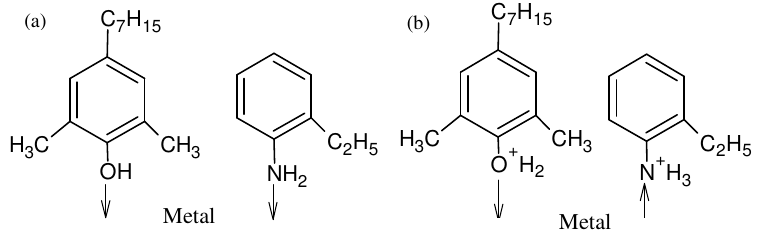
Figure 10. Adsorption model for the binary inhibitor mixtures on the metal surface (a) Unprotonated EA and unprotonated NPH (b) Protonated EA and protonated